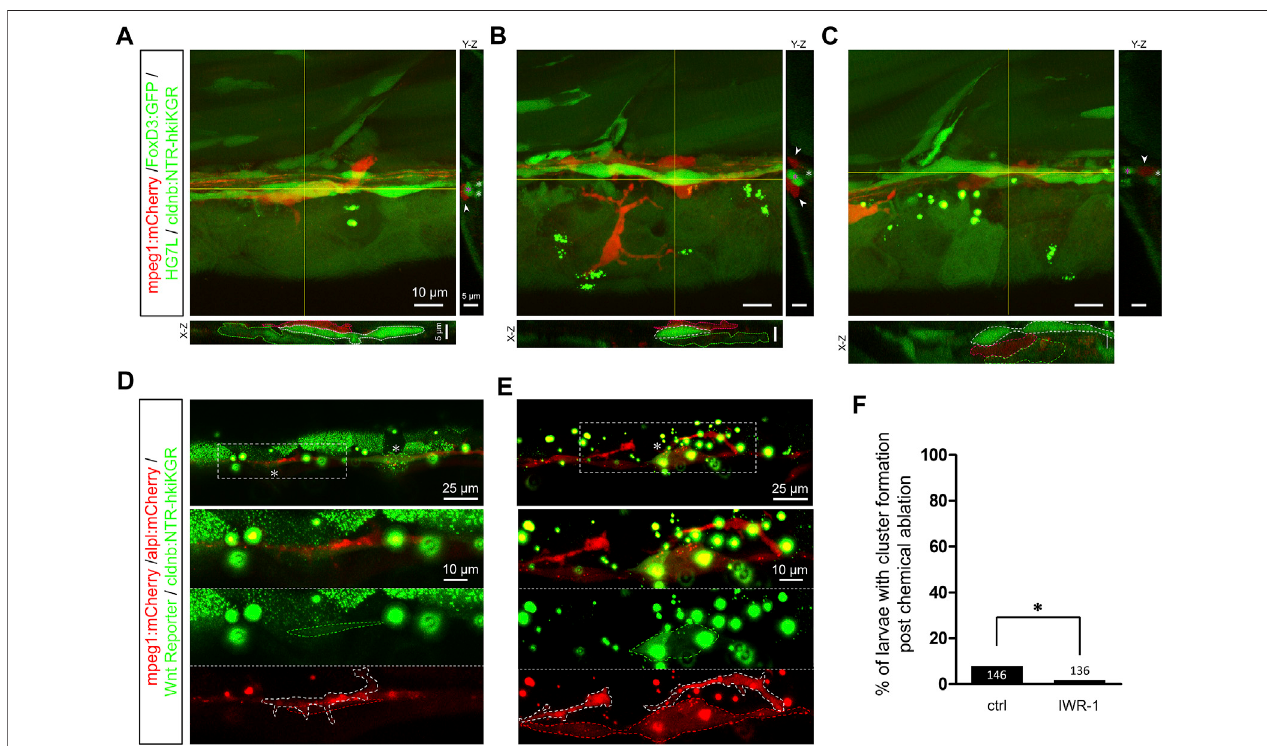
FIGURE8| In fi ltratedmacrophagesarefoundbetweenSchwanncellsandinterneuromastcellswithhigherWntactivityinMtz-treatedlarvae. (A – C) Imagesshown are representative confocal stacked images of Mtz-treated larvae from the cross of Tg(mpeg1:mCherry;FoxD3:GFP) and Tg[ − 8.0cldnb:NTR-hKikGR;Et(HG7L)] in orthogonal views, while the X-Z and Y-Z views at the position of yellow lines are shown below and on the right side, respectively. Macrophages (red) indicated by red dashedoutlinesweremostlycrawlingoninterneuromastcells(INCs,brightergreen,markedbywhitedashedoutlines)in (A – B) .Insomecases,macrophageswere foundbetweenINCsandSchwanncells(SWCs,dimgreen,labeledbygreendashedoutlines) (C) .Scalebarsarethesamebutonlyprovidedin (A) forrespectiveimages. (D and E) Images presented are representative stacked confocal images of Mtz-treated larvae from the cross of Tg (mpeg1:mCherry; − 8.0cldnb:NTR-hKikGR) and Tg( − 4.7alpl:mCherry;6XTcf/LefBS-miniP:d2GFP) . Areas shown higher Wnt activity are boxed with dash lines and indicated by asterisks. Magni fi ed diagrams for the dashed rectangles are shown in different color channels to reveal INCs (red, top panel), Wnt signal (dim green, dashed region, middle panel), and macrophage (red, dashedregion,bottompanel).Interestingly,somemacrophages(enclosedwithawhitedashedline)interactedwiththeseactivatedINCs.Thescalebargoesto25 μ mor 10 μ m in magni fi ed diagrams. (F) Larvae were treated without (Ctrl) or with IWR-1 to disrupt Wnt activity, and the percentages of larvae with cluster formation were counted as described previously. Data represent mean ± s.e.m. and were analyzed by one-way ANOVA, * p < 0.05.